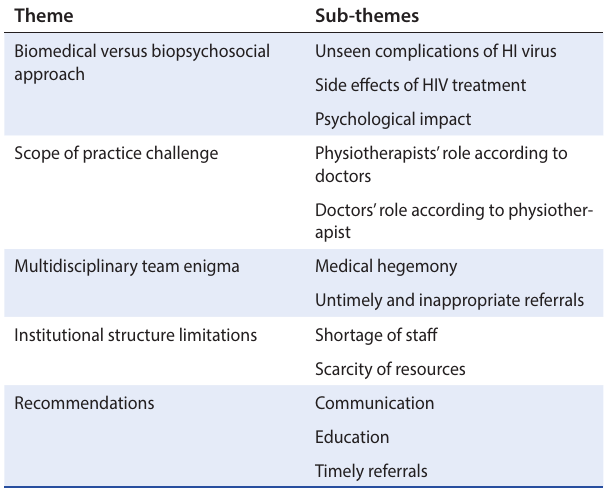
Table 1: Themes and